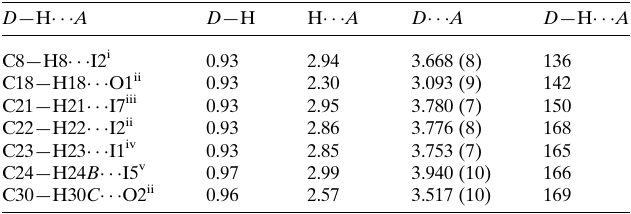
Table 1 Hydrogen-bond geometry (A˚ , (cid:4) ).